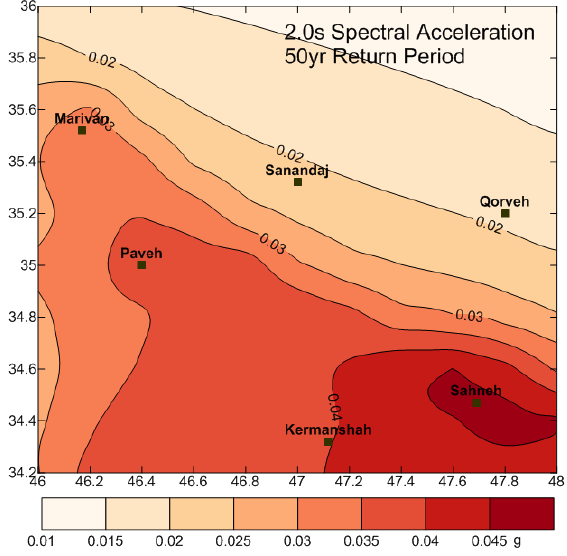
Figure 6. Seismic hazard map of the Kermanshah-Sanandaj region in terms of Sa(2.0 s) for the 475-year return